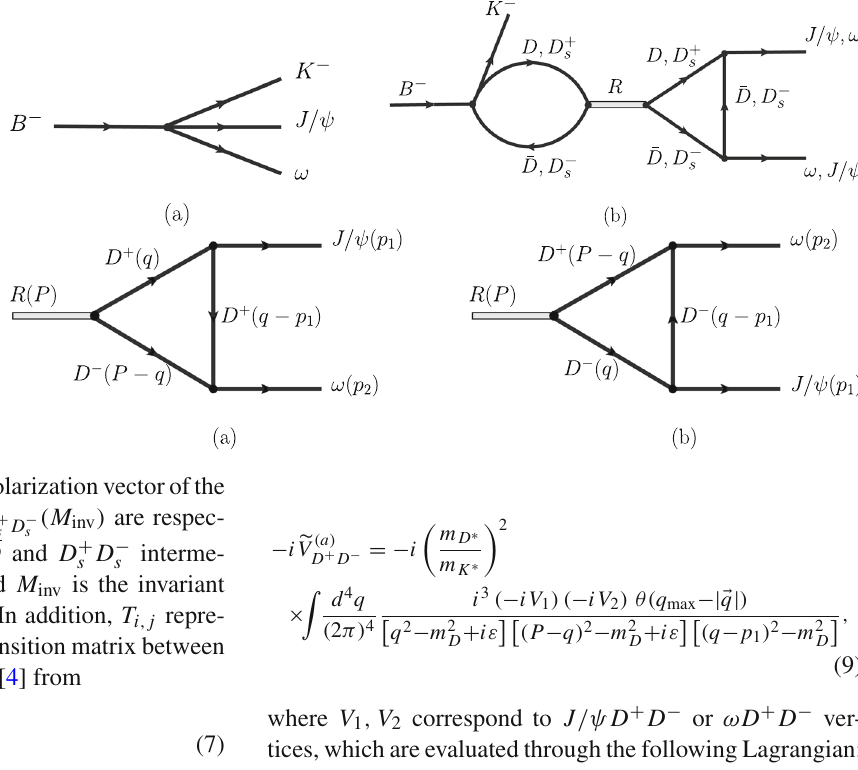
Fig. 3 Mechanisms for the B − → J /ψ ω K − decay. a Tree-level contribution. b Primary D ¯ D , D + s D − s